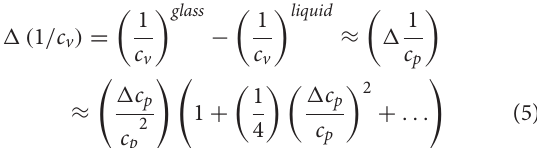
associated with higher energy modes of vibration, often occurring in interatomic bonds in a glass. These two types of energy, kinetic and potential, represent the degrees of freedom of motion which classically contribute to the heat capacity of a